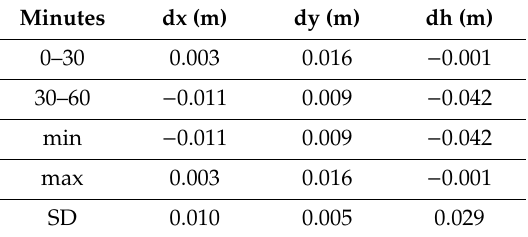
Table 14. 30 min sub-session positioning results summary, baseline OPNT–P30Pro (4 km).